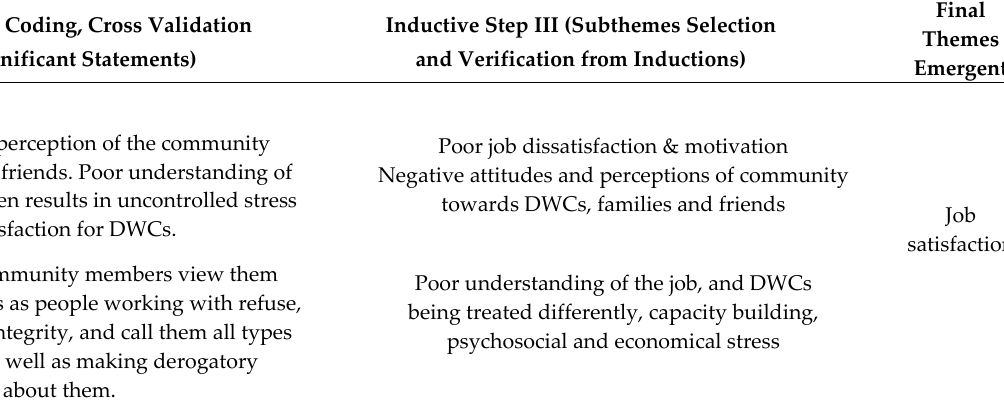
Table 2. Cont . Int. J. Environ. Res. Public Health 2020 , 17 ,